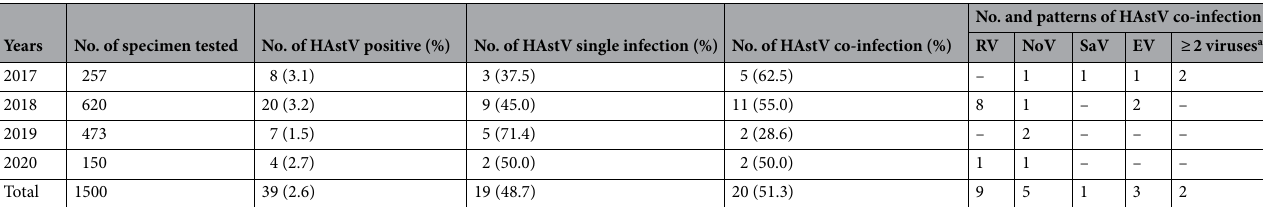
Table 1. Prevalence of HAstV infection and co-infection in children hospitalized with acute gastroenteritis in Chiang Mai, Thailand during 2017–2020. RV rotavirus, NoV norovirus, AdV adenovirus, EV enterovirus, SaV sapovirus. a HAstV co-infection with other two or more enteric viruses; RV + NoV (n = 1); AdV + NoV + EV (n = 1).